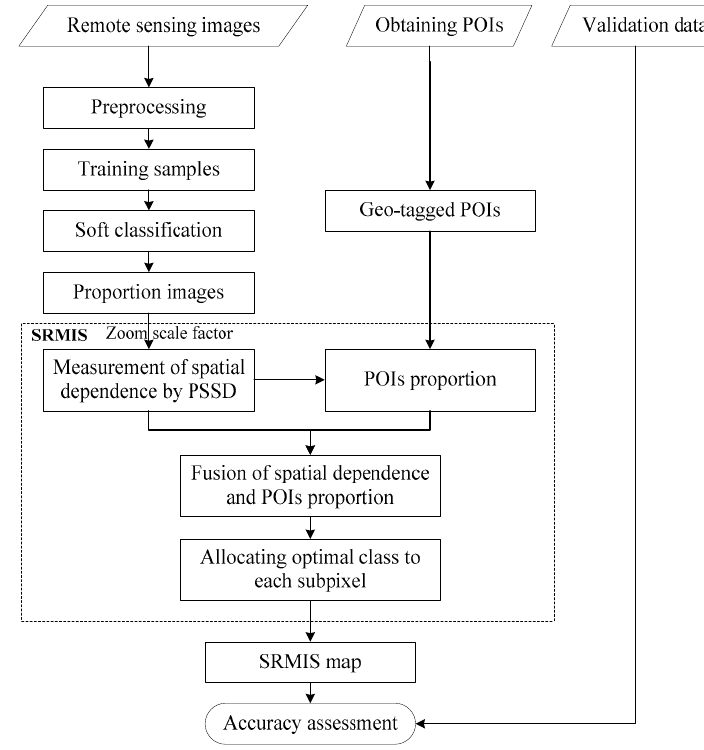
Figure 2. Flowchart of the